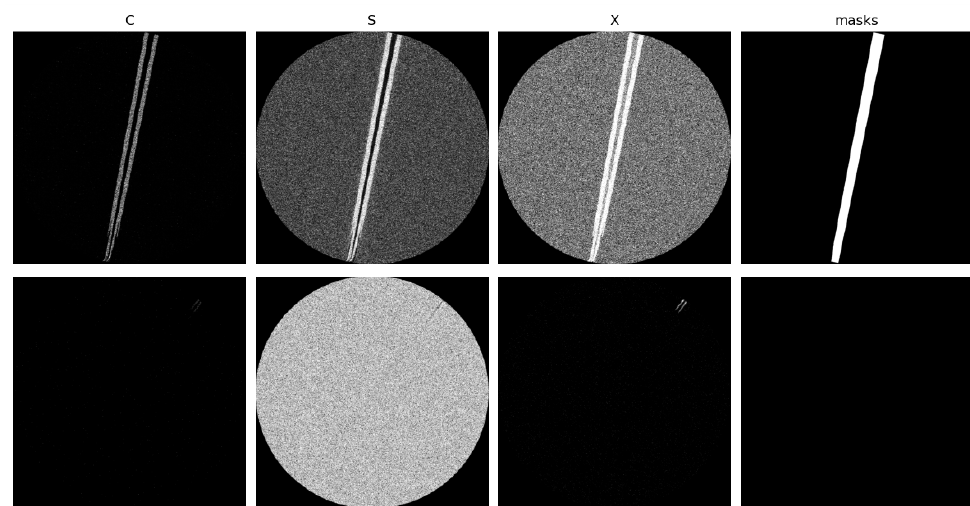
Figure 4. Circular cropping is applied to the images so that rotation augmentations do not create triangular clippings that are seen in Figure 1. Any time a rotation is applied to these images, there is no change in the amount or shape of overall information in the image—only the orientation of the wake. Note that there is no persistent wake for the images in the second row, and therefore there is no mask.